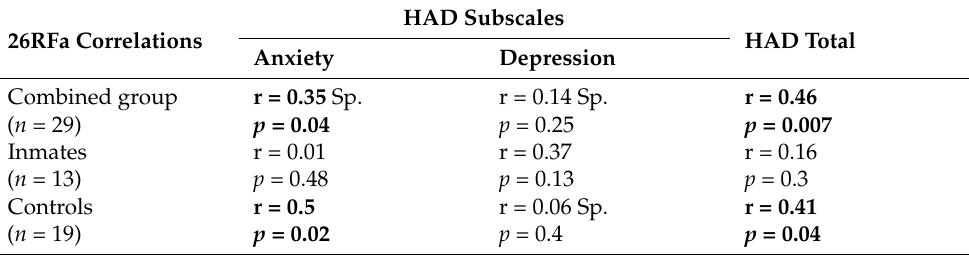
Table 2. Correlations between HAD total and subscale anxiety and depression scores with plasma concentrations of 26RFa in the combined group of men which includes inmates who committed aggressive acts, as well as men from the general population as controls and in the latter two groups separately. In the combined group, 3 high levels 26Rfa outliers of the inmate group have been removed. Significant correlation coefficients (Pearson’s or Spearman’s (Sp.) -r), with corresponding p -values, are shown in bold.